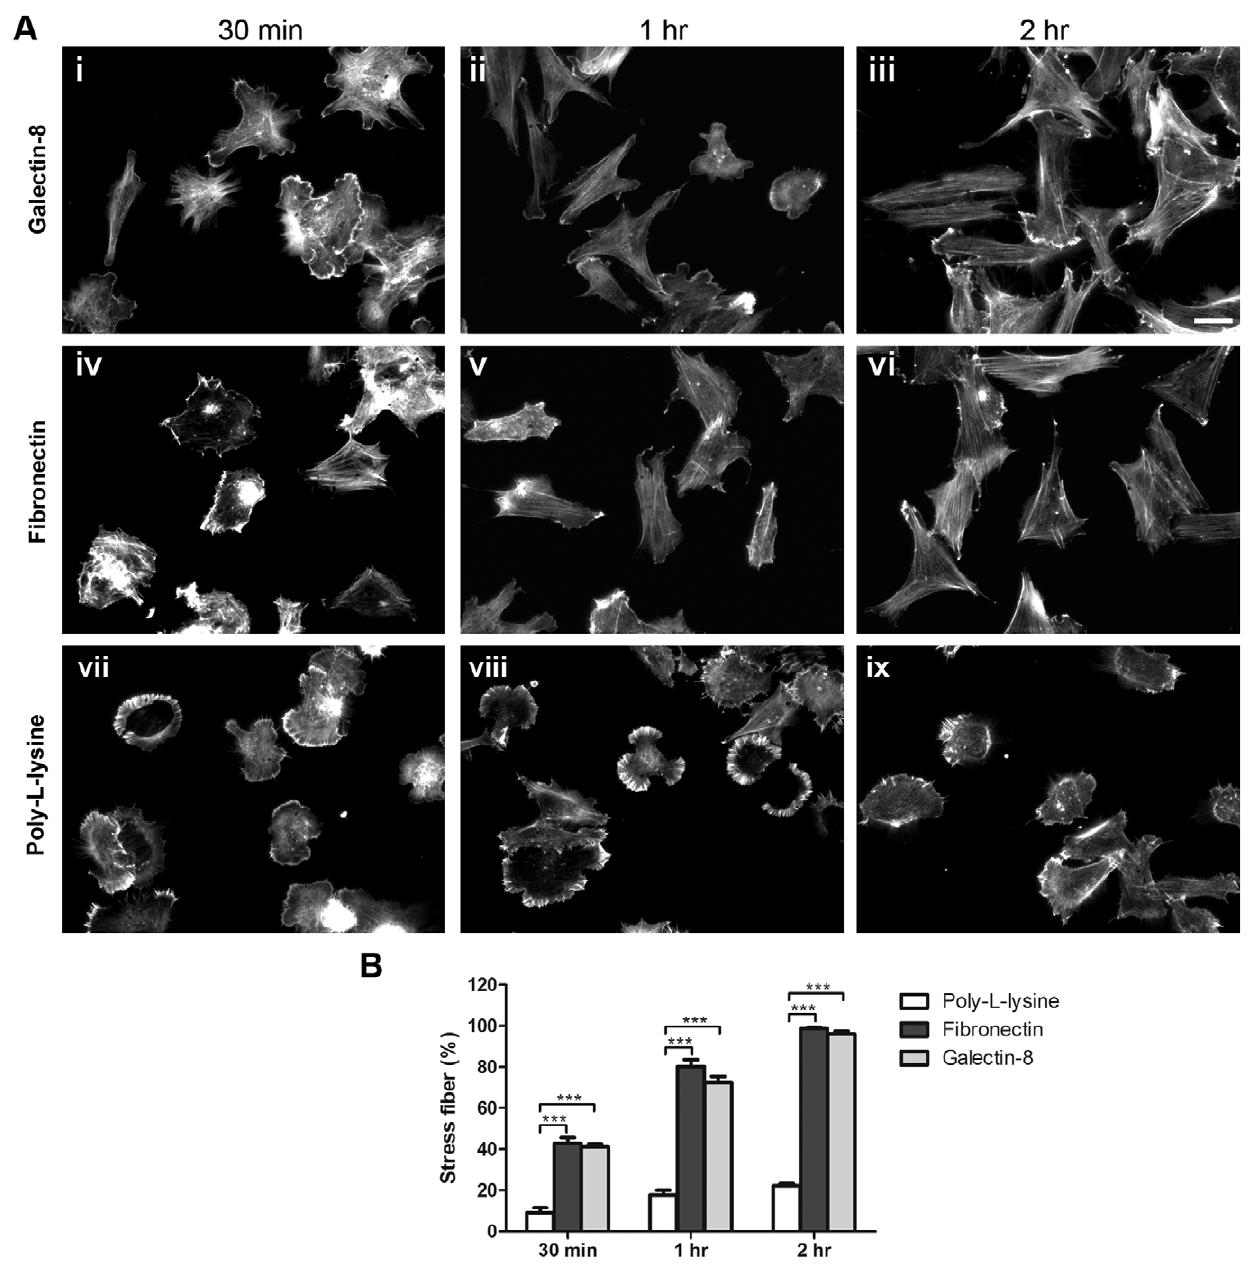
Figure 3. Galectin-8 promotes cytoskeletal rearrangement in TM cells. A: Normal human TM cells were plated on eight-chamber glass slides coated with 20 m g/ml of recombinant human Gal8 (i–iii), 20 m g/ml of fibronectin (iv–vi), or 100 m g/ml of poly-L-lysine (vii–ix) in serum-free DMEM at 37 u C for 30 min (i, iv, vii), 1 hr (ii, v, viii), and 2 hr (iii, vi, ix). Following the incubation period, cells were fixed with 4% paraformaldehyde and stained with rhodamine-labeled phalloidin. Bar: 50 m m. B: Quantification of stress fiber formation. Random fields were photographed, and cells with robust stress fibers were counted. N=225 to 362. Data are expressed as mean 6 SEM and analyzed with one-way ANOVA. *** P , 0.001 vs poly-L-lysine at different time points. This experiment was performed three times with reproducible